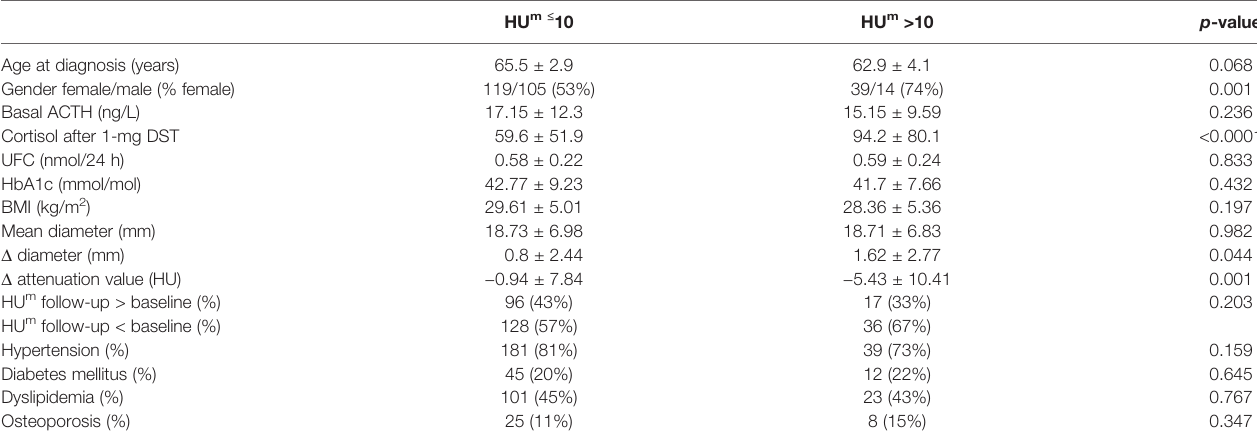
FIGURE 2 | Bar chart depicting D diameter (A) or D attenuation (B) in patients with NFAI (light gray bar) or ACS (dark gray bar) according to short, intermediate, or TABLE 3 | Clinical and radiological data of patients, sorted by attenuation value.